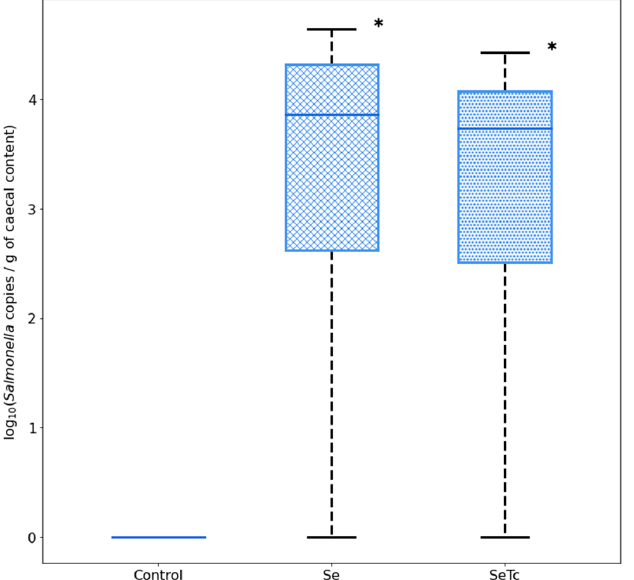
Figure 5. Quantification of S. Infantis load in samples of broiler chickens treated with a microalgae- based diet. Values are medians plus their respective interquartile ranges (n = 8). Asterisk denotes differences with the control group. Se: S. Infantis group; SeTc: S. Infantis + T. chuii group.